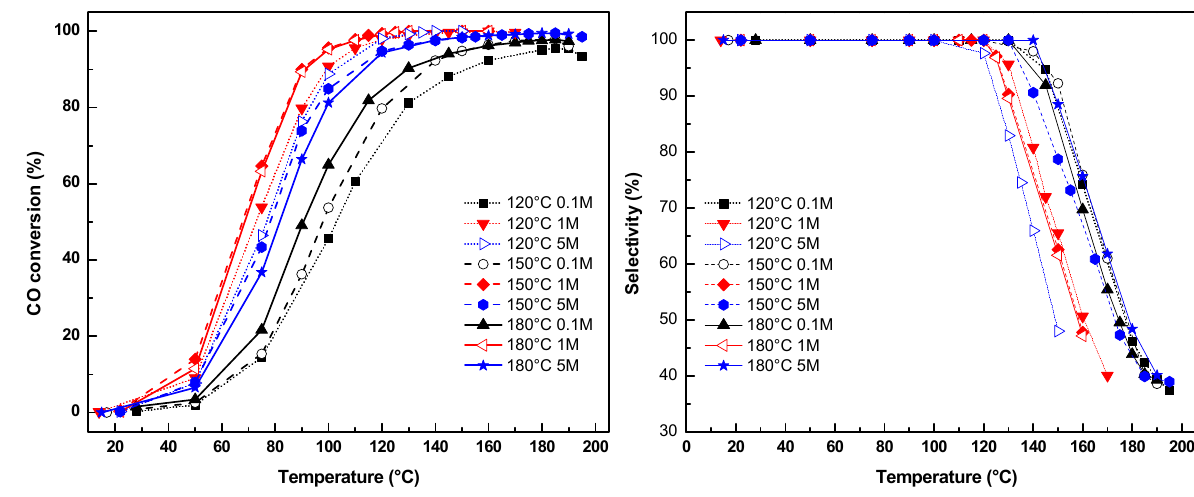
Figure 7. CO conversion and selectivity curves for the CuCe oxide catalysts.